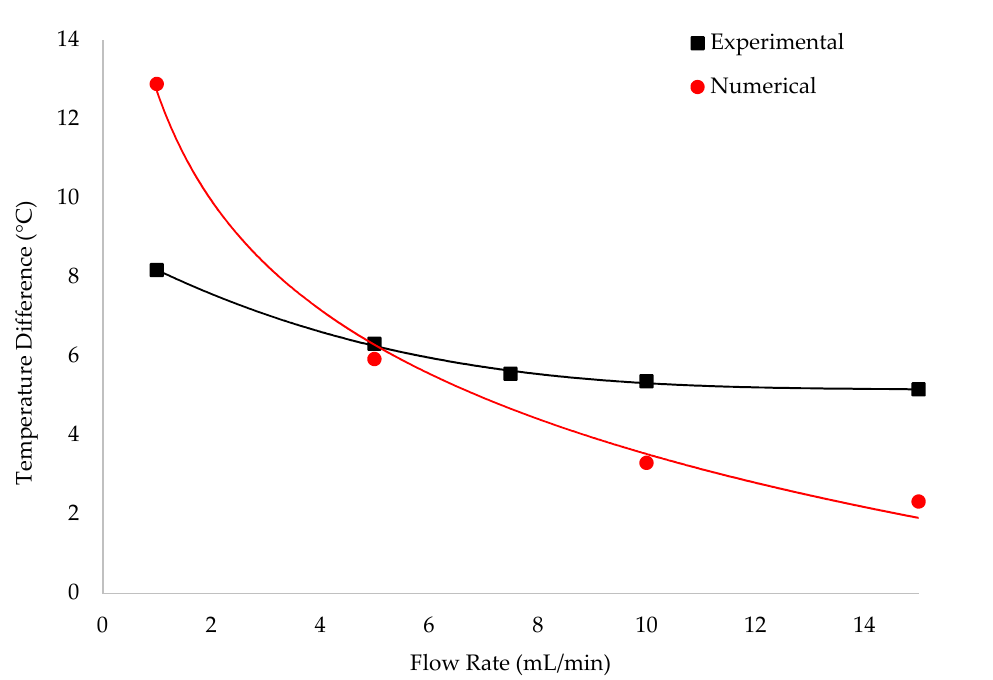
Figure 9. Comparison of the difference in temperature generated in the experimental tests and in the numerical simulation.